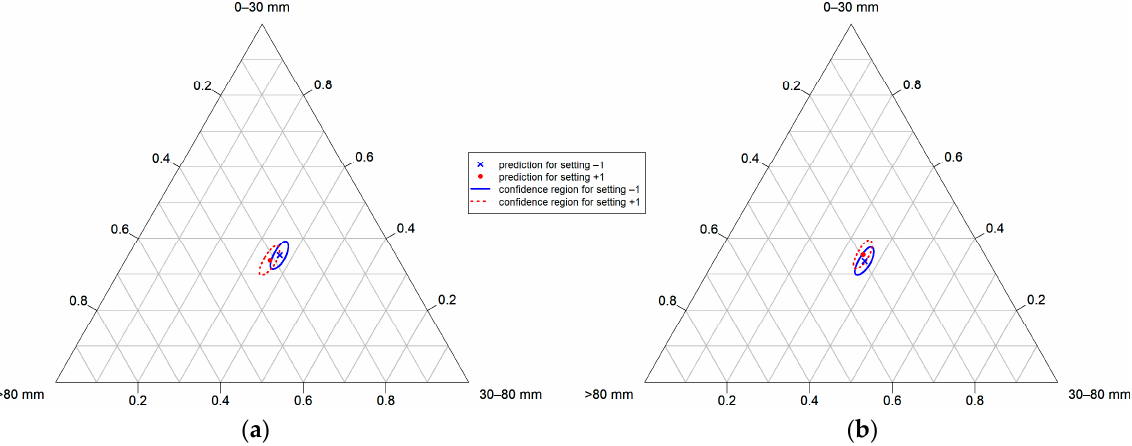
Figure 5. Ninety percent confidence regions for the minimum ( − 1) and maximum (+1) settings of w ( a ) and s ( b ), at factor setting 0 for the corresponding other factors of w , s , c 1 and c 2 , based on the linear model from Equation